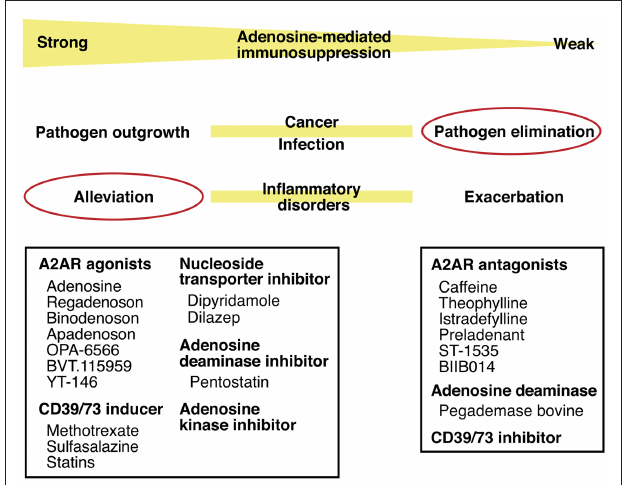
FIgure 4 | Intervention in pathophysiological conditions by modulating the adenosine-A2Ar pathway. Enhancement of the adenosine-mediated immunosuppression can be done by directly stimulating A2AR using agonists or by increasing adenosine levels using CD39/73 inducer or inhibitors of nucleoside transporter, adenosine deaminase, and adenosine kinase. This treatment should alleviate various inflammatory disorders. Conversely, weakened adenosine-dependent immunosuppression is expected to enhance anti-pathogen immune response. This modulation will be possible by inhibiting extracellular adenosine production (CD39/73 inhibitor), by enhancing adenosine degradation (adenosine deaminase), or by blocking adenosine binding to